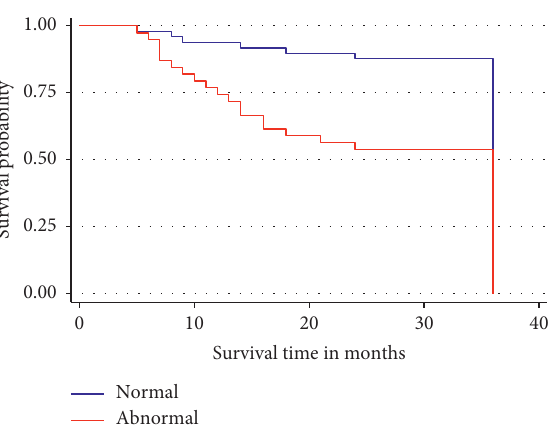
Figure 3: Three-year overall survival by Gleason score group of the patients. Patients with Gleason score > 7 show a relatively increased risk of dying compared to those with Gleason score ≤